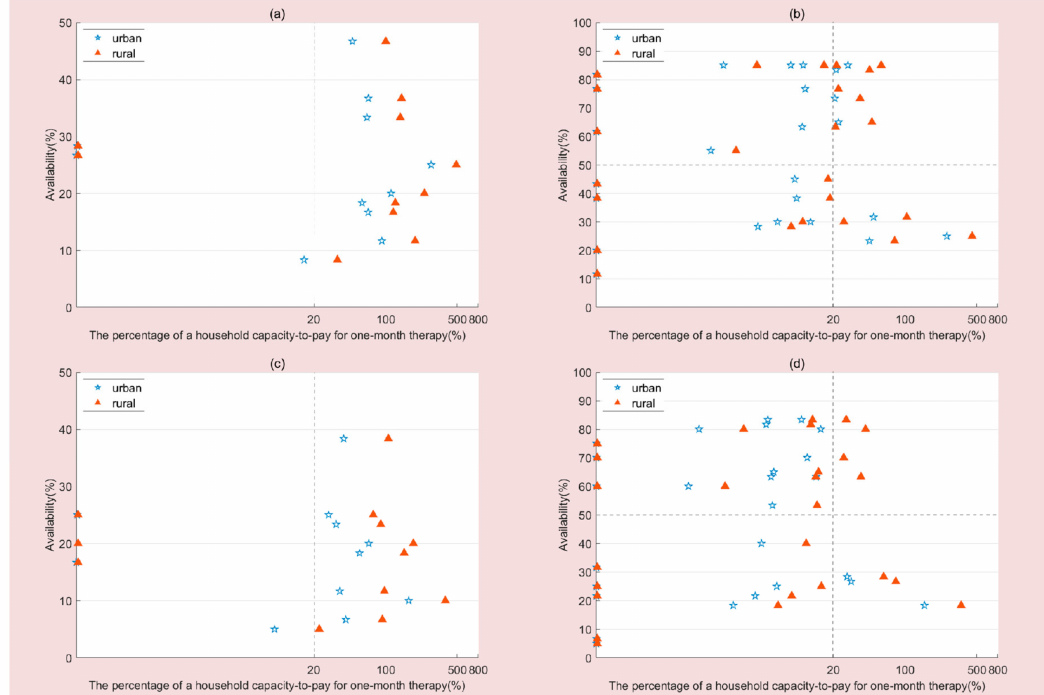
Figure 2. Comprehensive analysis of medicine availability and a ff ordability after insurance